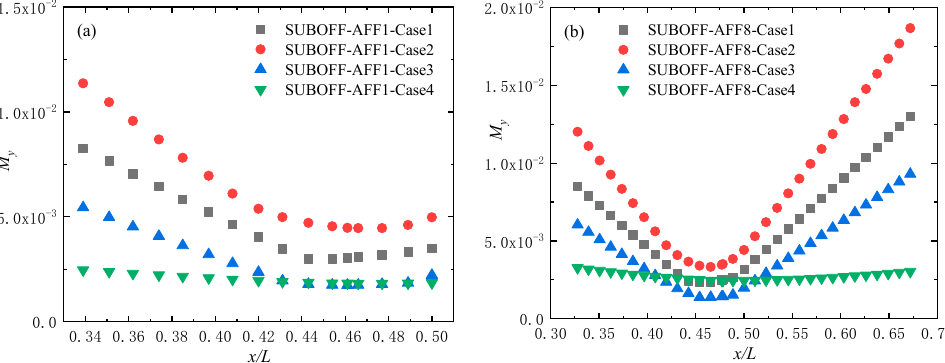
Figure 22. Nondimensional moment peak value of SUBOFF-AFF-1 ( a ) and SUBOFF-AFF-8 ( b ).